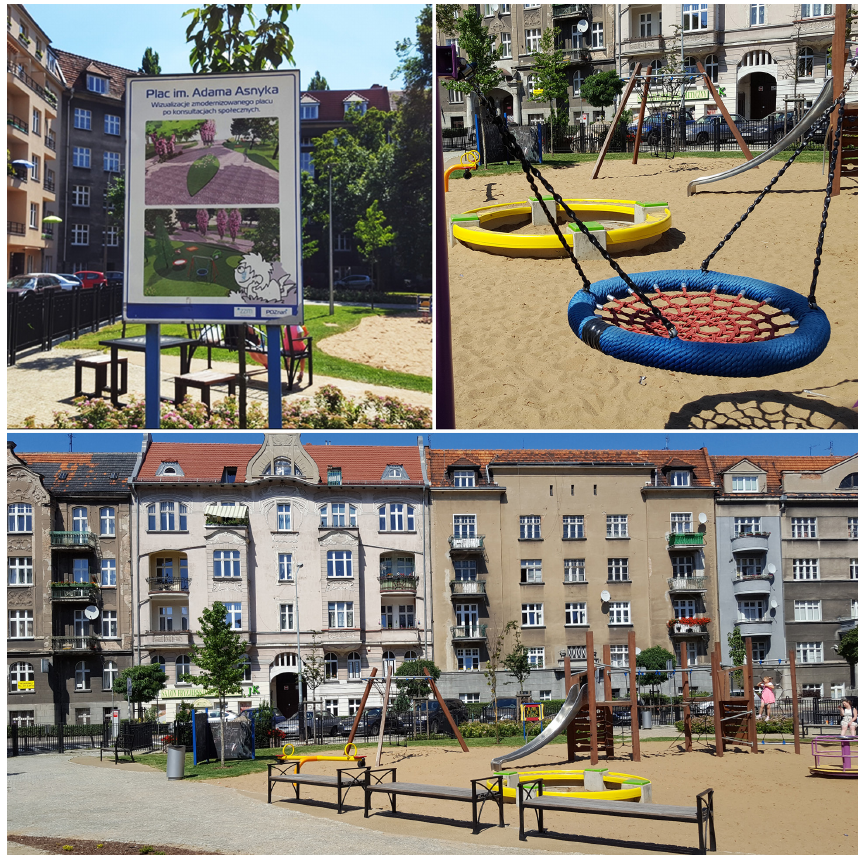
Fig. 2. Asnyk Square after